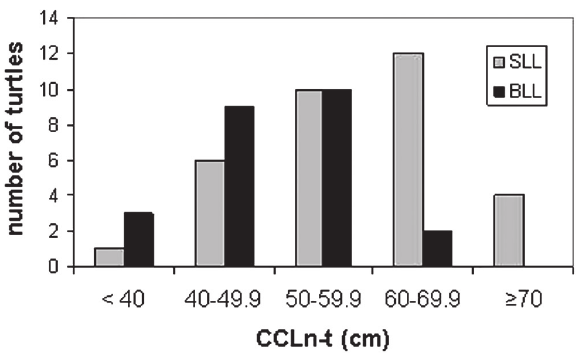
Fig . 2. – distribution of Curved Carapace length (CCln-t) frequen- cies of loggerhead turtles caught in the study area by Surface lon-